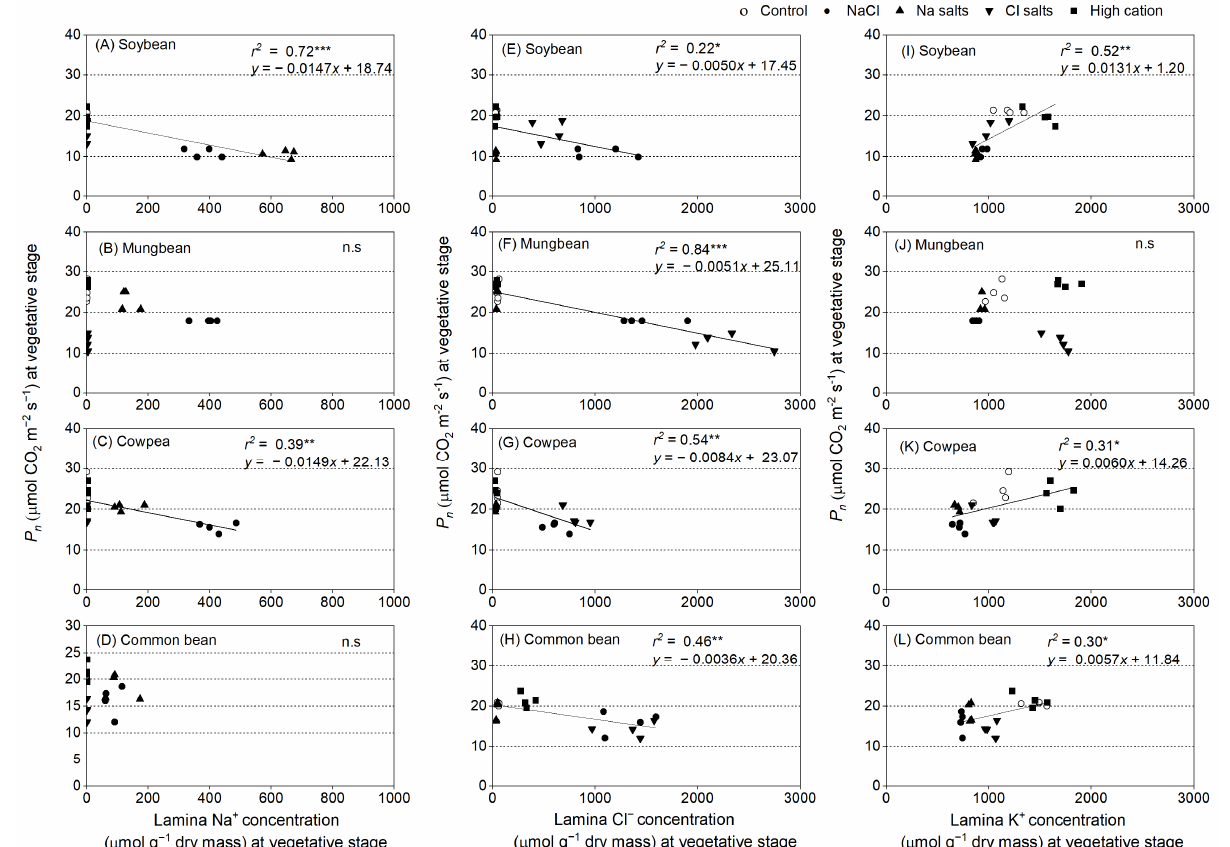
Figure 7. Scatter plots of net photosynthesis ( P n ) versus ( A – D ) lamina Na + concentration, ( E – H ) lamina Cl – concentration, ( I – L ) and lamina K + concentration of soybean, mungbean, cowpea, and common bean grown in control (non-saline; open circles), 100 mM NaCl (solid circles), 100 mM Na + (without Cl – ) (solid, upward triangles), 100 mM Cl – (without Na + ) (solid, downward triangles), and high-cation negative control (solid squares) (K + , Mg 2+ , and Ca 2+ equivalent to those in the 100 mM Cl – ) treatments. The salts used in the various treatments are given in Table 1. Treatments were imposed on 13 day- old plants with gas exchange measured after 13–14 (vegetative stage) days of treatment between 09:00 and to 15:00 at photosynthetically active radiation of 1500 µmol photons m –2 s –1 , CO 2 concentration of 400 µmol mol –1 , 28 C leaf chamber temperature, and 60–70% relative humidity. Each value is an individual replicate, and each replicate is one plant grown in a different pot. * significant at p < 0.05, ** significant at p < 0.01, *** significant at p < 0.001, and n.s. = not significant.